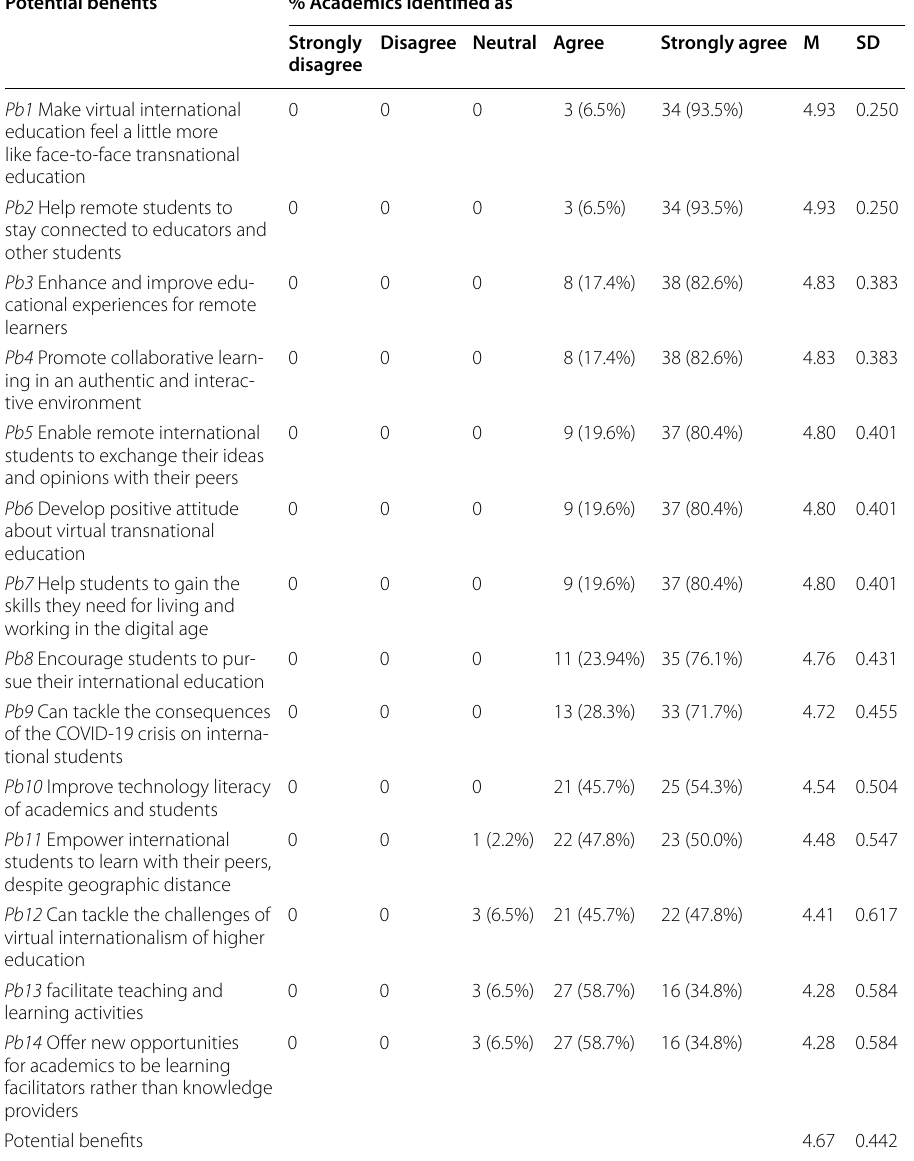
Table 11 Academics’ responses regarding the potential benefits of employing telepresence robots in virtual transnational